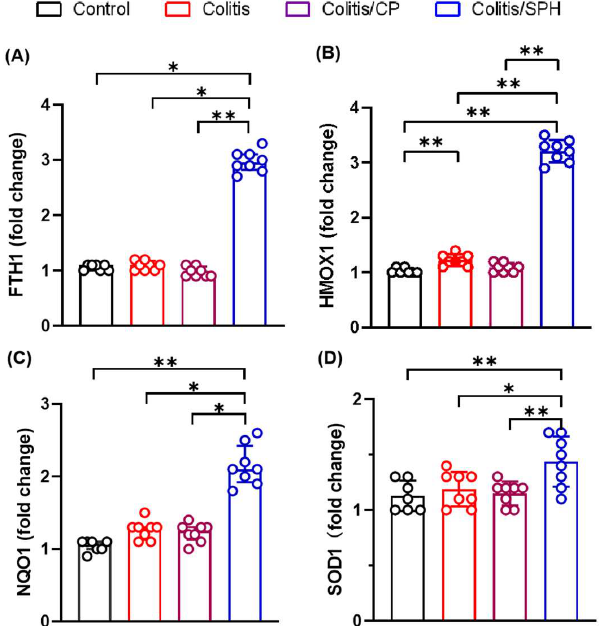
Figure 7. SPH upregulates the expressions of anti-oxidative genes in TNBS-induced colitis model. ( A – D ) Assessment of the mRNA expressions of FTH1 (ferritin heavy chain 1), HMOX1 (heme oxygenase 1), NQO-1 (NAD(P)H quinone oxidoreductase 1), and SOD1 (superoxide dismutase 1, soluble) genes in colon tissues using RT-PCR. The numbers of mice in the four groups were 7, 8, 8, and 8, respectively. Data are presented as mean ± SD and analyzed by one-way ANOVA test in ( B , D ), while median and interquartiles (Q1:Q3) and Kruskal–Wallis test were used in ( A , C ). **: p < 0.01, *: p < 0.05.